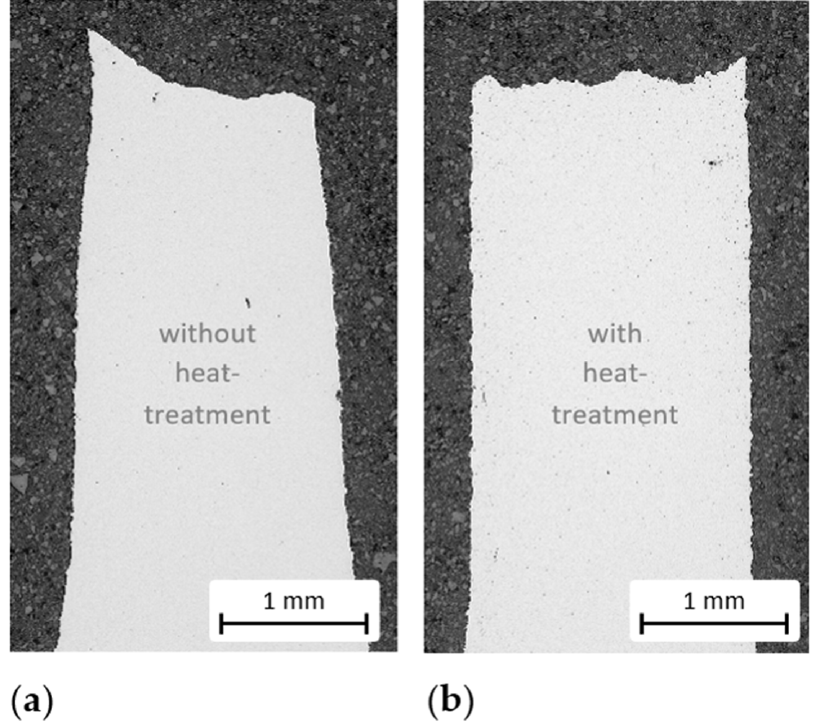
Figure 5. Optical micrographs of the fracture zones of the tensile tested specimens: ( a ) as-sintered and ( b ) heat-treated. The as-sintered specimens exhibited pronounced necking, which indicates higher formability in comparison to the heat treated material.